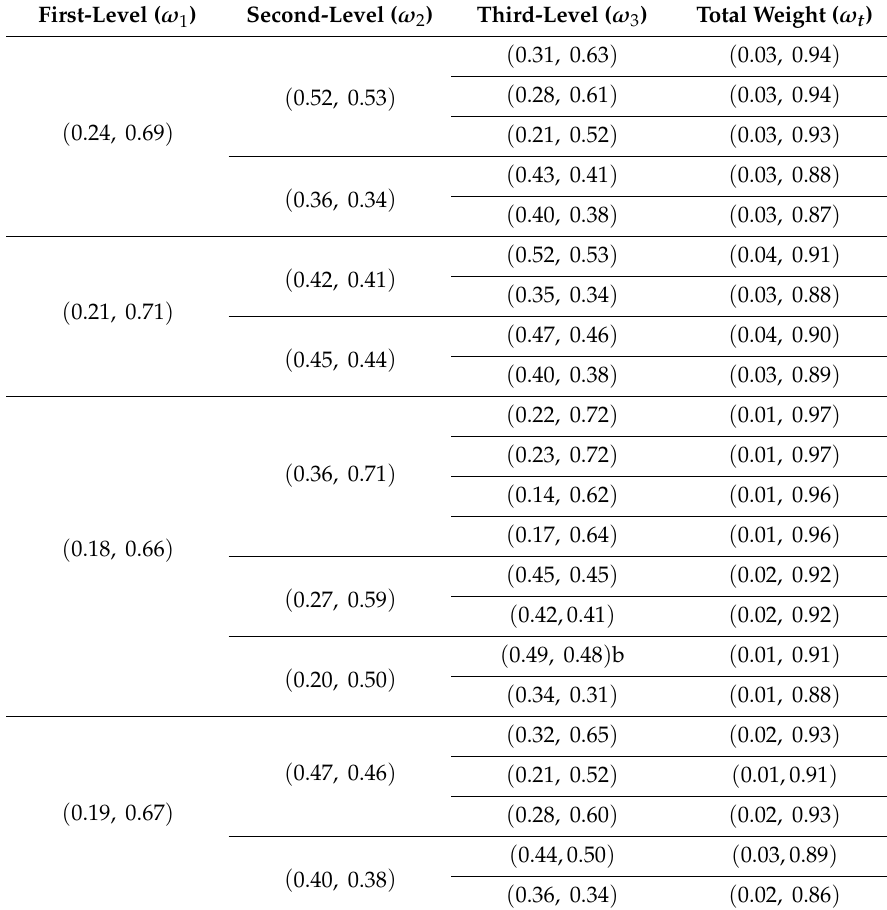
Table 9. Total weight of A